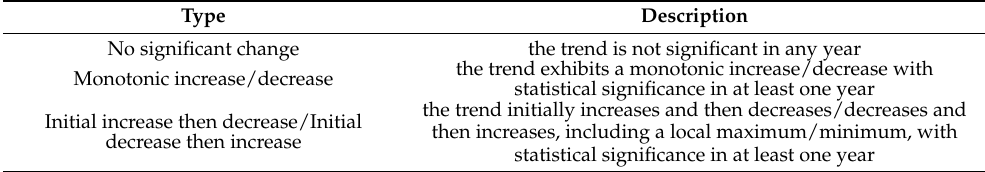
Table 2. The nonlinear trend of the